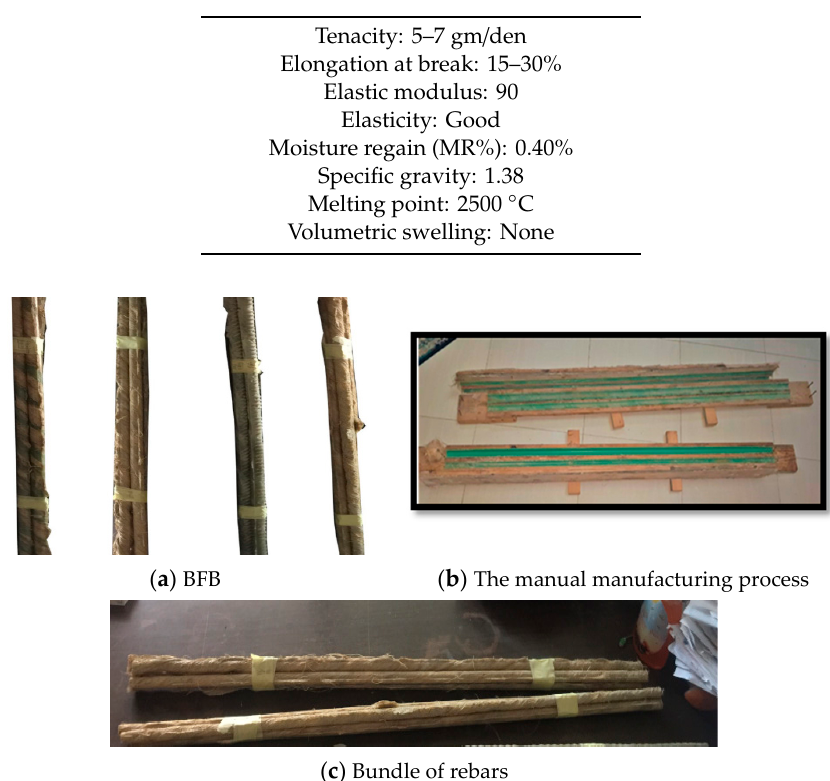
Figure 4. Shapes and manufacturing process of banana fiber bars. Table 2. Phytochemical properties of polyester